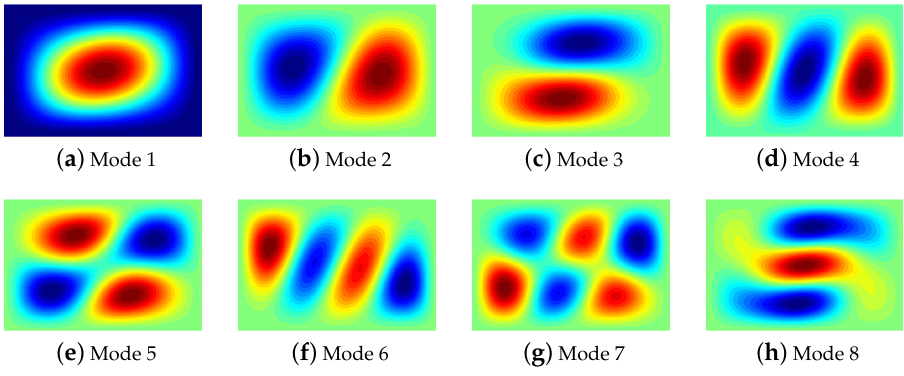
Figure 6. Vibration shapes of plates with layup [ (cid:104) 45 | 90 (cid:105) , (cid:104) 0 |− 45 (cid:105) , (cid:104) 0 | 45 (cid:105) , (cid:104)− 45 | 0 (cid:105) ] s .